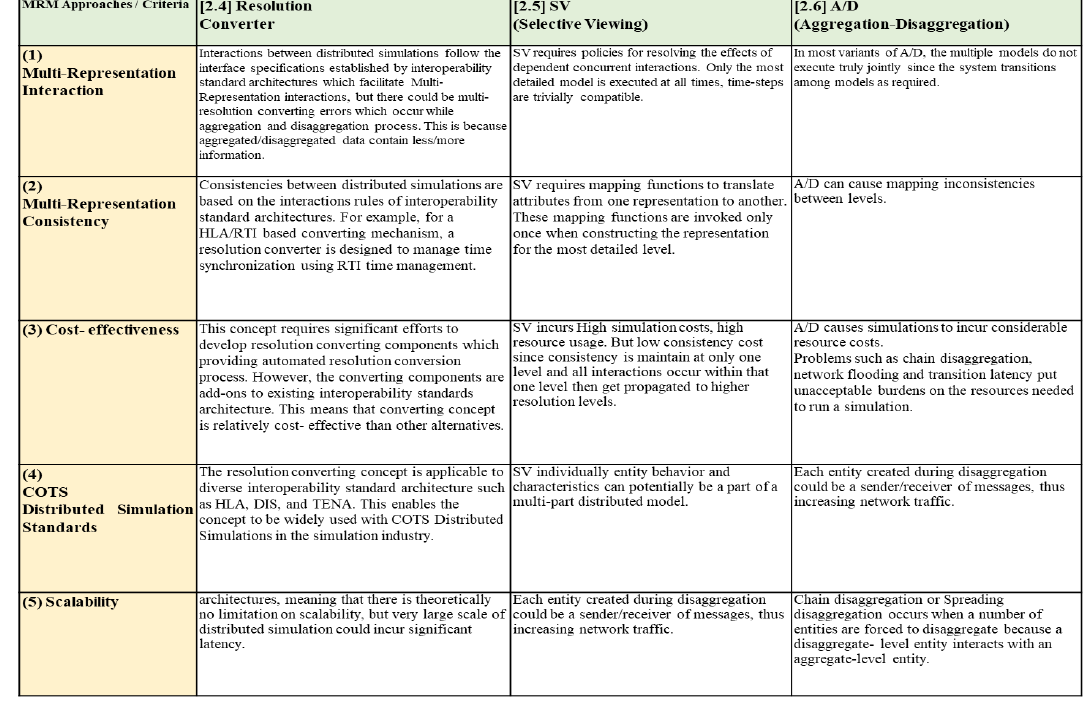
Figure 5. Second Group.